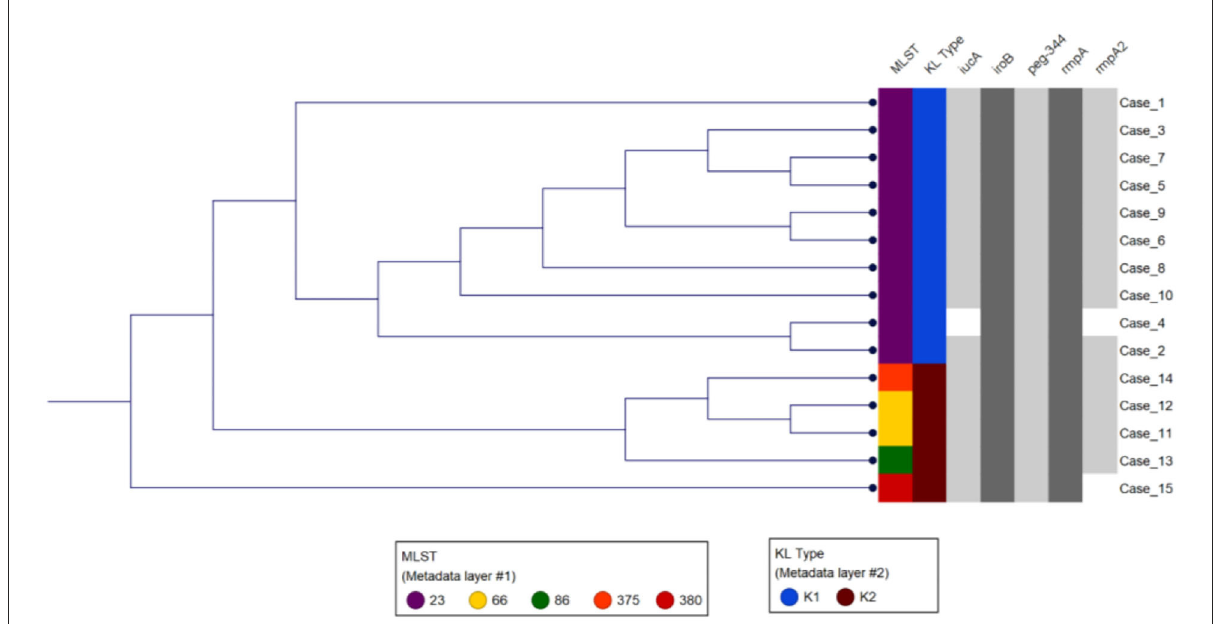
FIGURE1 Genetic analysis of the study isolates. The first two columns show the MLST and K type for each isolate. Phylogenetic analysis using K-mer grouped isolates based on the K type and MLST. The gray shaded columns indicate the virulence genes present in each of the